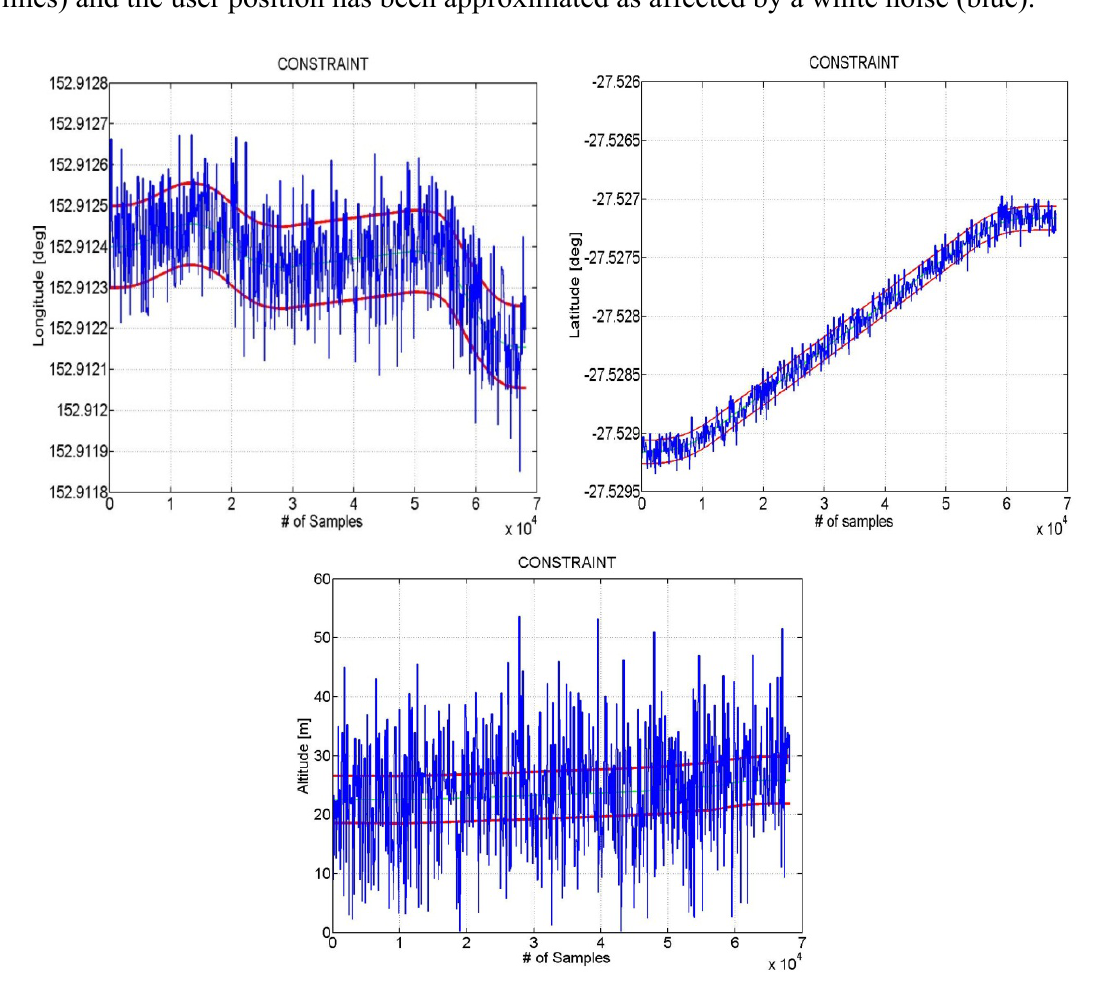
Figure 8. Example of constraints on position. The boundaries of the street are shown (red lines) and the user position has been approximated as affected by a white noise